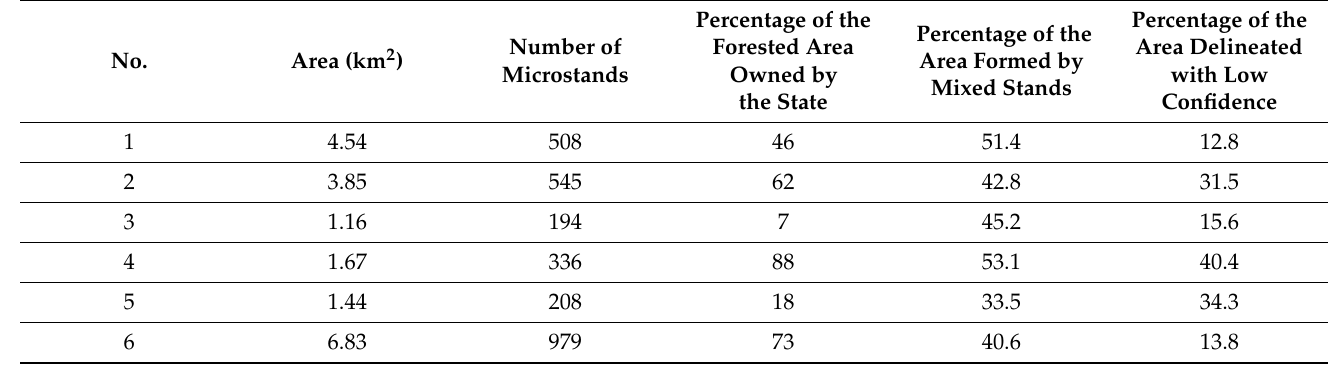
Table 1. Characteristics of the sample areas derived from the reference data.